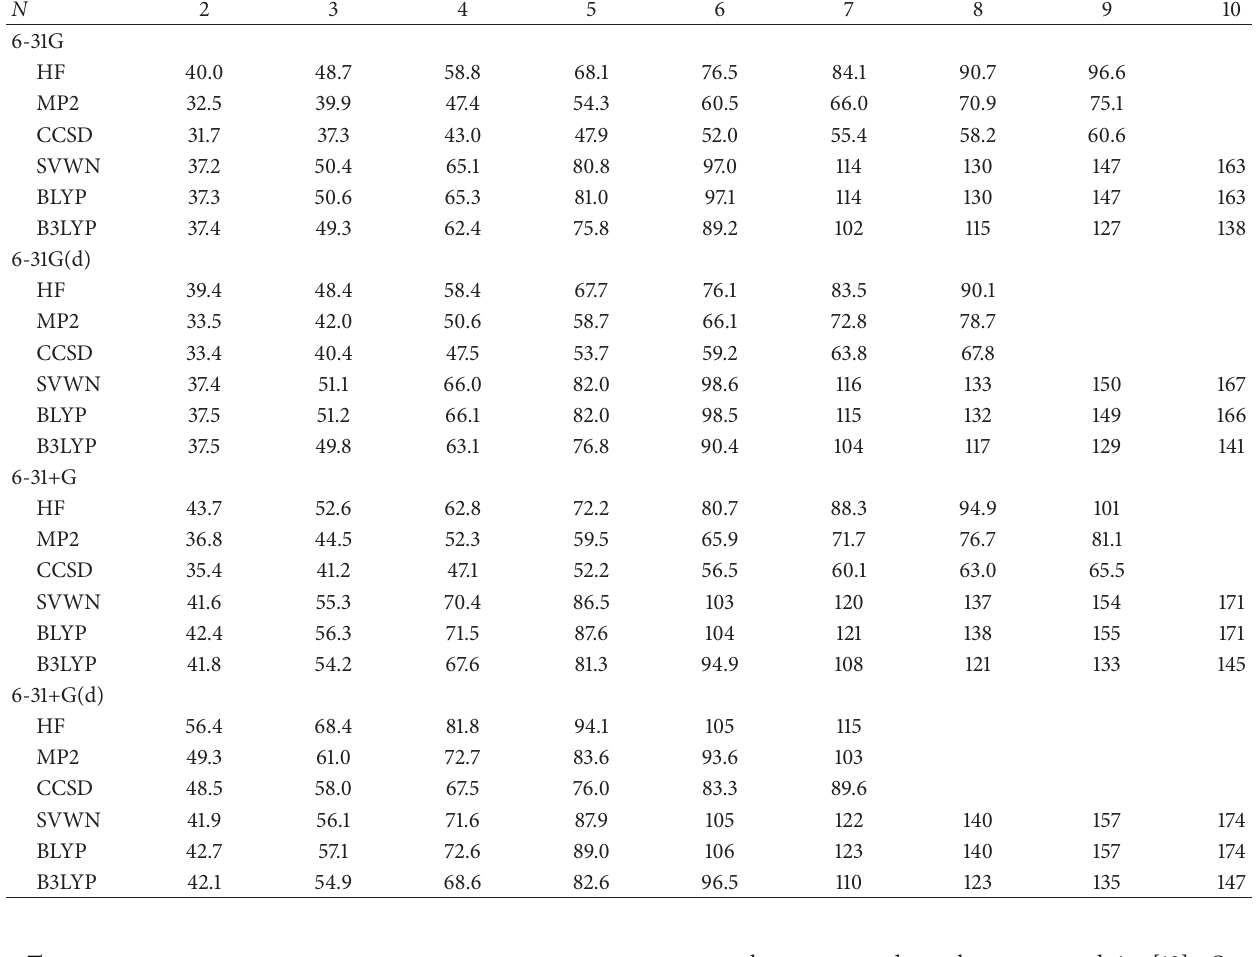
Table 1: Longitudinal polarizabilities per unit cell 𝛼 𝐿 /𝑁 of polyenes obtained by various chemical models (in a.u., N is the number of unit cells or double bonds in the system).